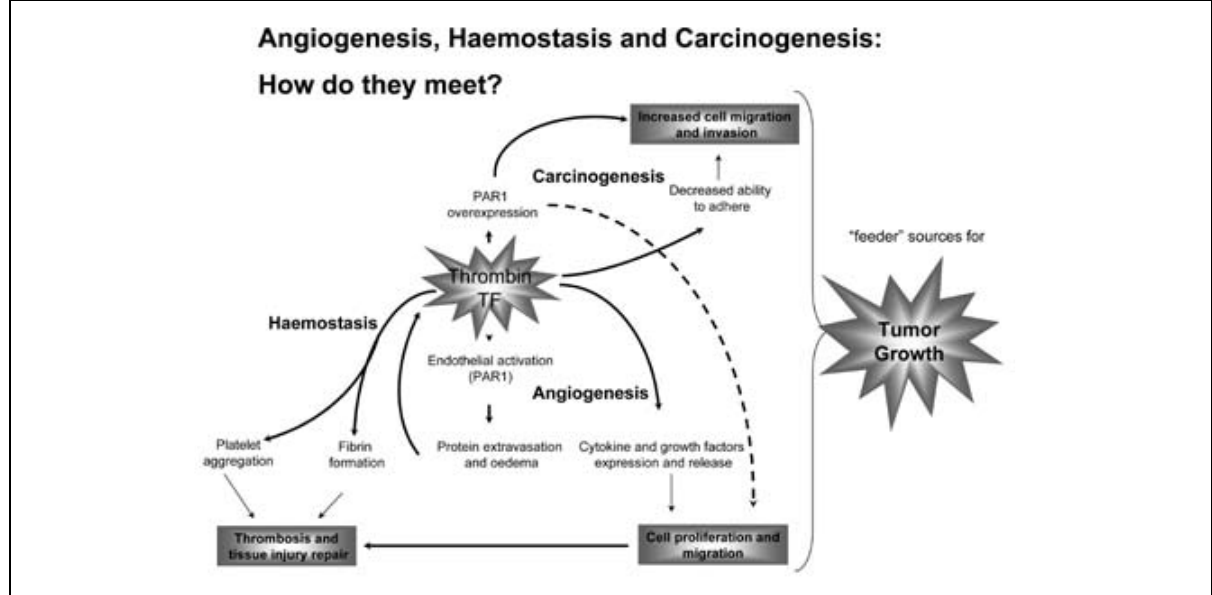
Figure 2 – The central actions of thrombin as mediator of blood coagulation cascade, angiogenesis and carcinogenesis. Thrombin is a multifunctional serine protease generated at a site of vascular injury, being the most effective agonist for platelet aggregation and activation. Thrombin also elicits a host of responses in the vascular endothelium, including shape and permeability changes, mobilization of adhesive molecules, and stimulation of different cytokines and growth factors, which when deregulated can promote the angiogenic switch leading to an exaggerated neovascularization, frequently detected in several tumours. Thrombin is also able to activate endothelial PAR1, which is known to be up-regulated in different tumours types. Therefore, all these evidences suggest that during the process of tumour growth, angiogenesis as well as haemostasis can serve as “feeder” sources for the tumour cells, underlying a close relationship among